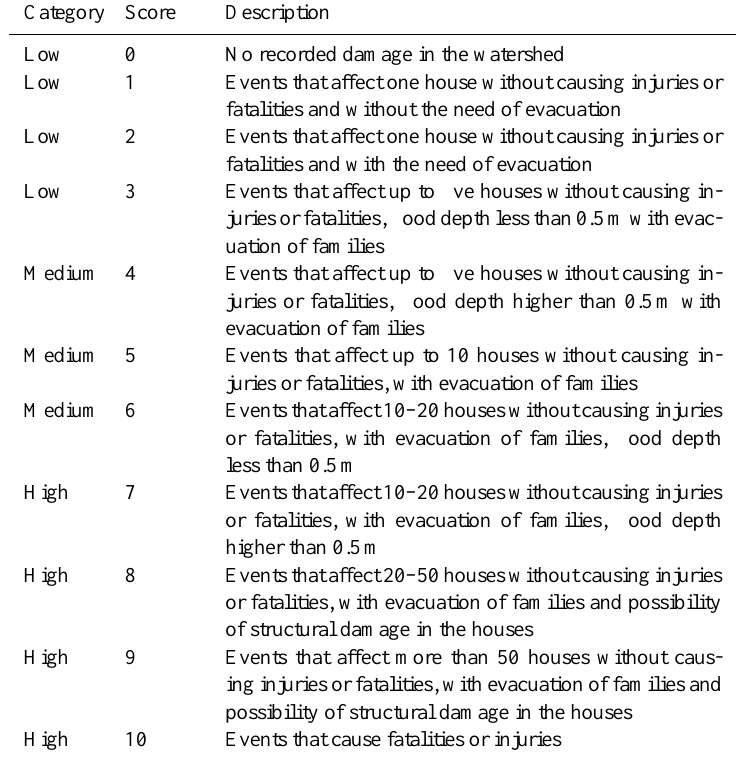
Table 3. Categories of recorded damage Category Score Description Low 0 No recorded damage in the watershed Events that affect one house without causing injuries or fatalities and without the need of evacuation Events that affect one house without causing injuries or fatalities and with the need of evacuation Events that affect up to five houses without causing in- juries or fatalities, flood depth less than 0.5m with evac- uation of families Events that affect up to five houses without causing in- juries or fatalities, flood depth higher than 0.5m with Events that affect up to 10 houses without causing in- juries or fatalities, with evacuation of